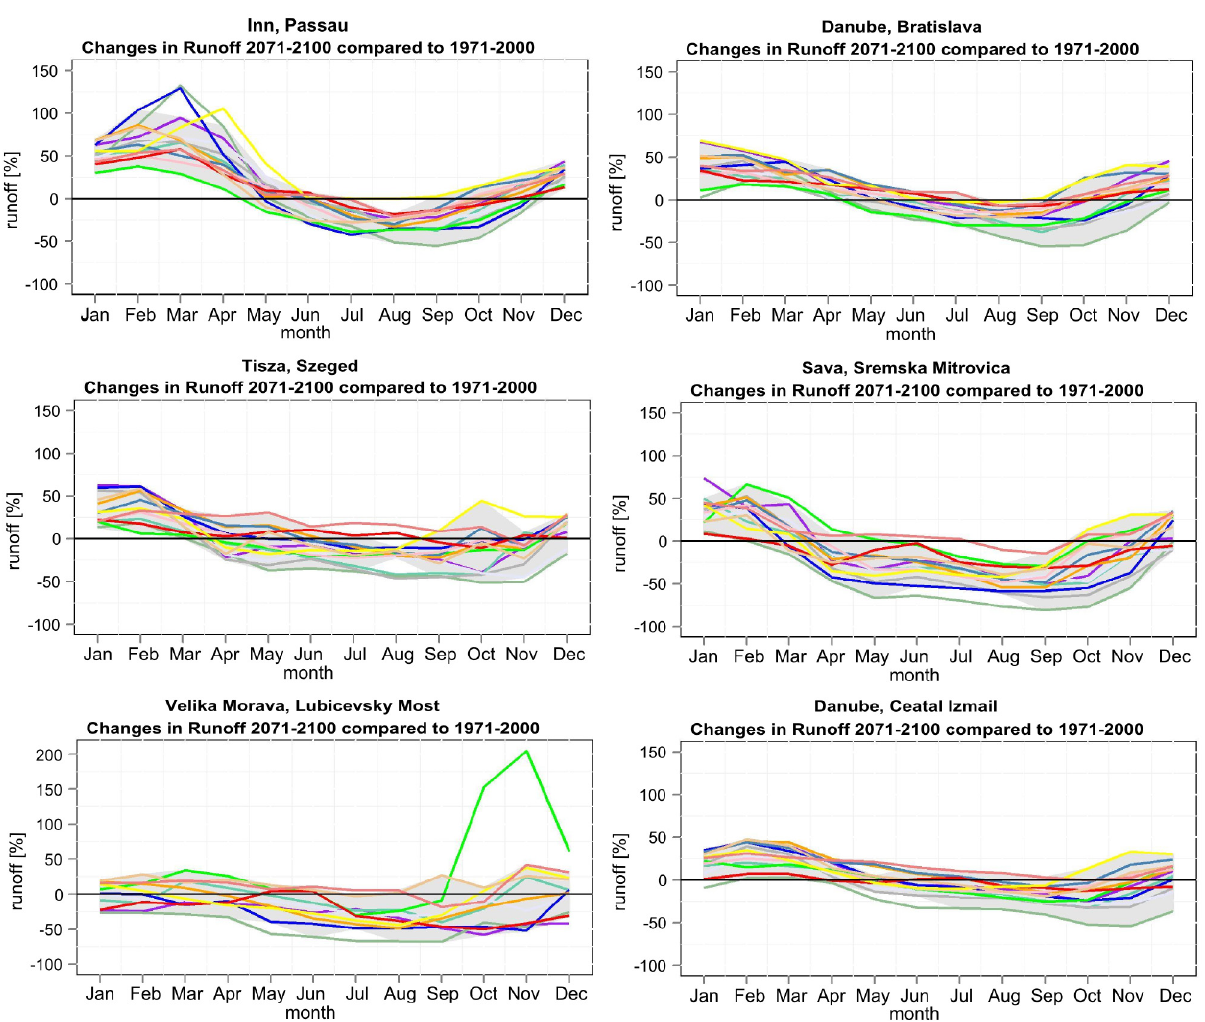
Figure 13. Changes (%) in the mean runoff seasonality between the reference period 1971–2000 and the far future scenario period 2071–2100 for selected stations in the Danube River catchment driven by the ENSEMLBES scenarios. The grey ribbon comprises the range of results without